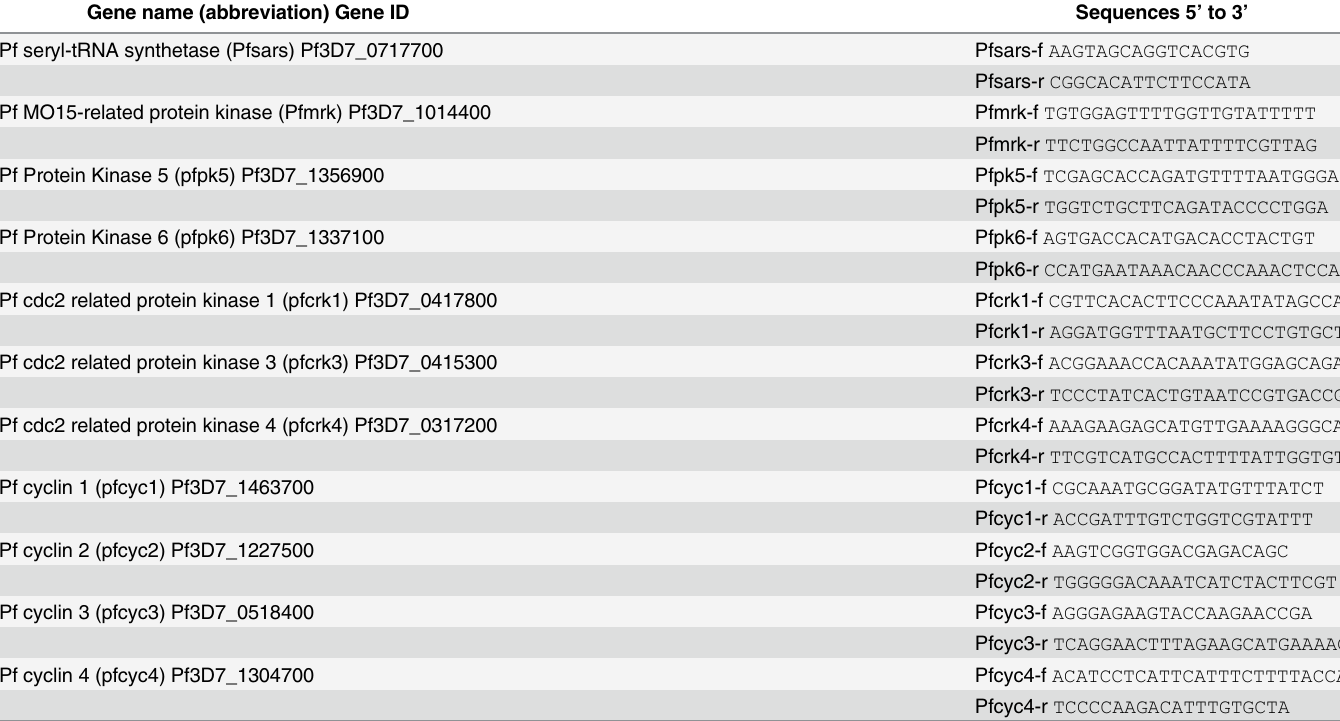
Table 1. P . falciparum gene names (abbreviation), ID numbers and primers used for amplification of CDKs and cyclins. The seryl-tRNA synthetase gene was used as a positive